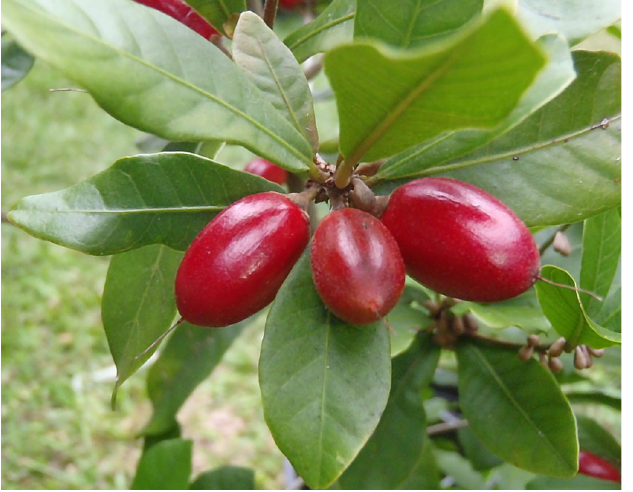
Fig. 3: Fruits of Synsepalum dulcificum Daniell